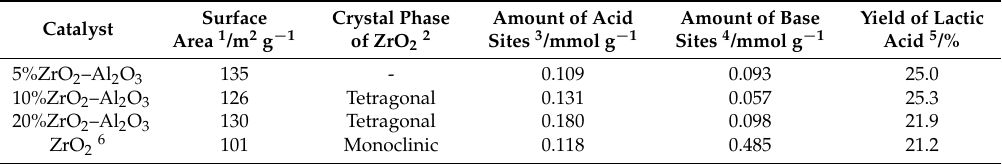
Table 1. Properties of the ZrO 2 –Al 2 O 3 and ZrO 2 catalysts.